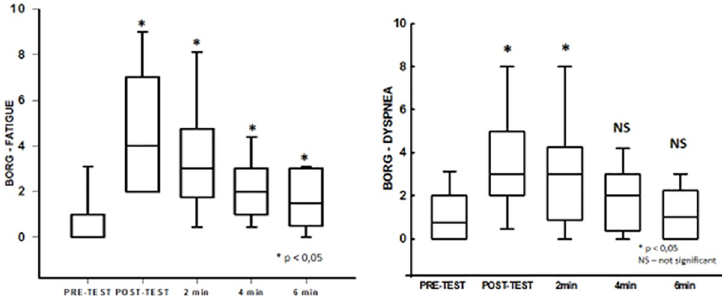
Fig 6. Upper limbs fatigue and dyspnea responses during and after 6-PBRT. Abbreviations: 6-PBRT, six-minute pegboard and ring test; min, minutes; NS, not significant; � significant difference when compared to basal values.